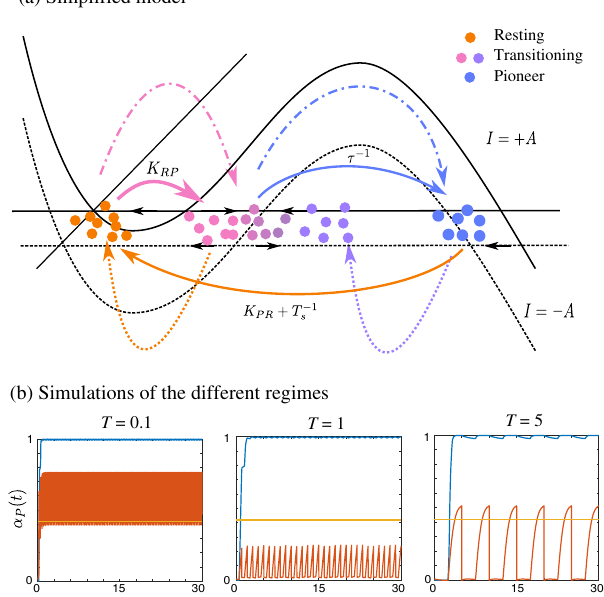
FIG. 6. Principle of the model of oscillations-induced desynch- ronization. (a) Phase plane of the toy model, with nullclines for I ¼ A (solid line) or I ¼ − A (dotted line), together with the three populations of cells: resting (orange), transitioning (pink to violet according to the value of v ), and pioneer (blue), together with the transitions at fixed input (solid lines) and at switching times from þ A to − A (dashed lines) or from − A to þ A (dot-dashed lines). (b) Simulation of the proportion of pioneers in the rest-pioneer model (blue) and in the three-population model (red) as a func- tion of time for increasing stimulation period. No qualitative change is observed in the rest-pioneer model (blue lines): for any frequency, a chain reaction is predicted. In the three-population rest-transitioning-pioneer model, we recover the phenomenon of Fig. 5. Left: For rapid oscillations, compensation of the pioneers does not occur, and the system eventually exceeds α (yellow c line). Middle: Optimal oscillation frequency. The system stabil- izes around the critical value with a mean below that value preventing spiking. Right: Slow oscillations synchronize the A; · Þ and K A; · Þ system to the input. In that model, K RP ð(cid:4) PR ð(cid:4) were computed numerically as in the previous section, with A ¼ 2 , τ ¼ 2 and the probability to switch is a sigmoidal (tanh) function of ð τω Þ − 1 with slope 4 and threshold 0.2, and the periods of stimulation chosen are, from left to right, T ¼ 0 . 1 , 1,